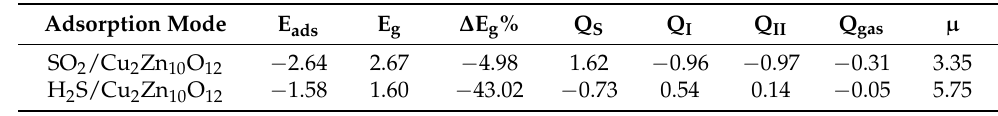
Table 1. The adsorption properties for SO 2 /Cu 2 Zn 10 O 12 and H 2 S/Cu 2 Zn 10 O 12 . The adsorption energy (E ads , eV), HOMO-LUMO gap (E g , eV), percentage change in HOMO-LUMO gap ( ∆ E g , %), NBO charges (Q, eV), and dipole moment ( µ , Debye).